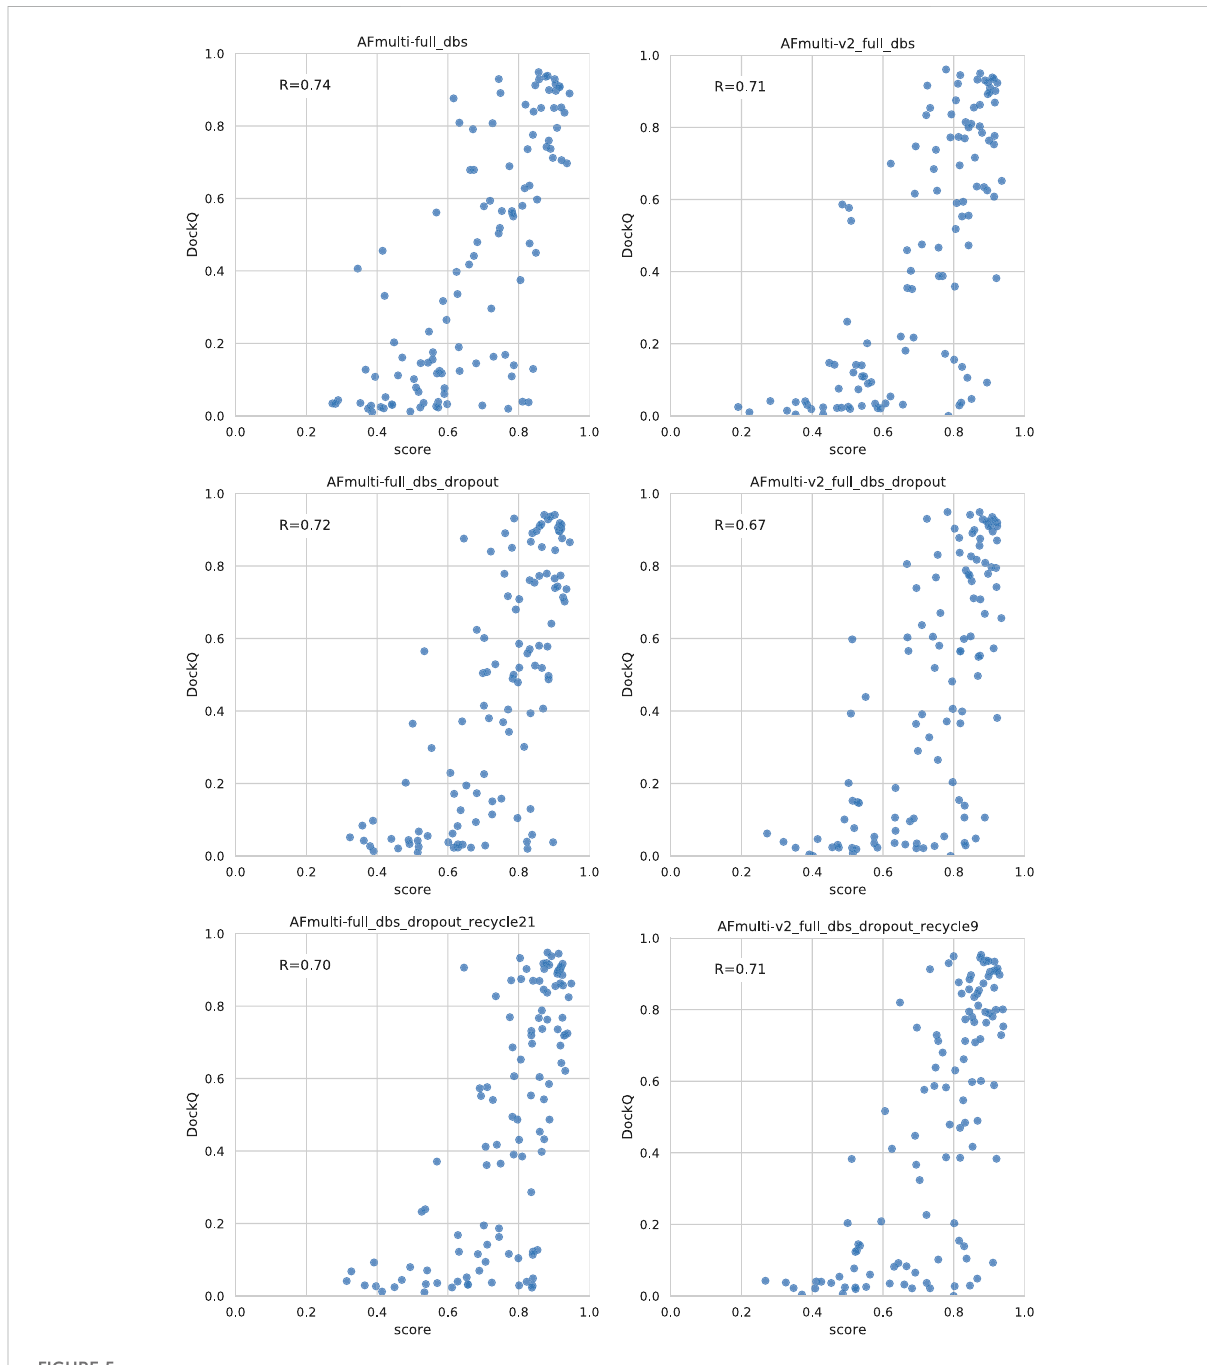
FIGURE 5 Correlation between method score and DockQ. The score is the ranking con fi dence